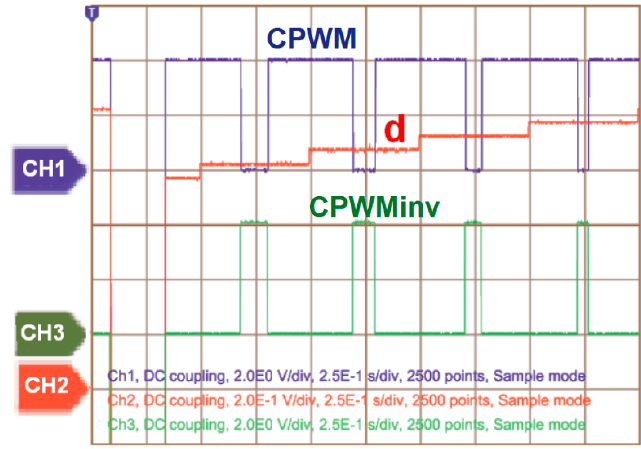
Figure 11. Outputs CPWM and CPWMinv controlled with d with one delay period (1Tp).